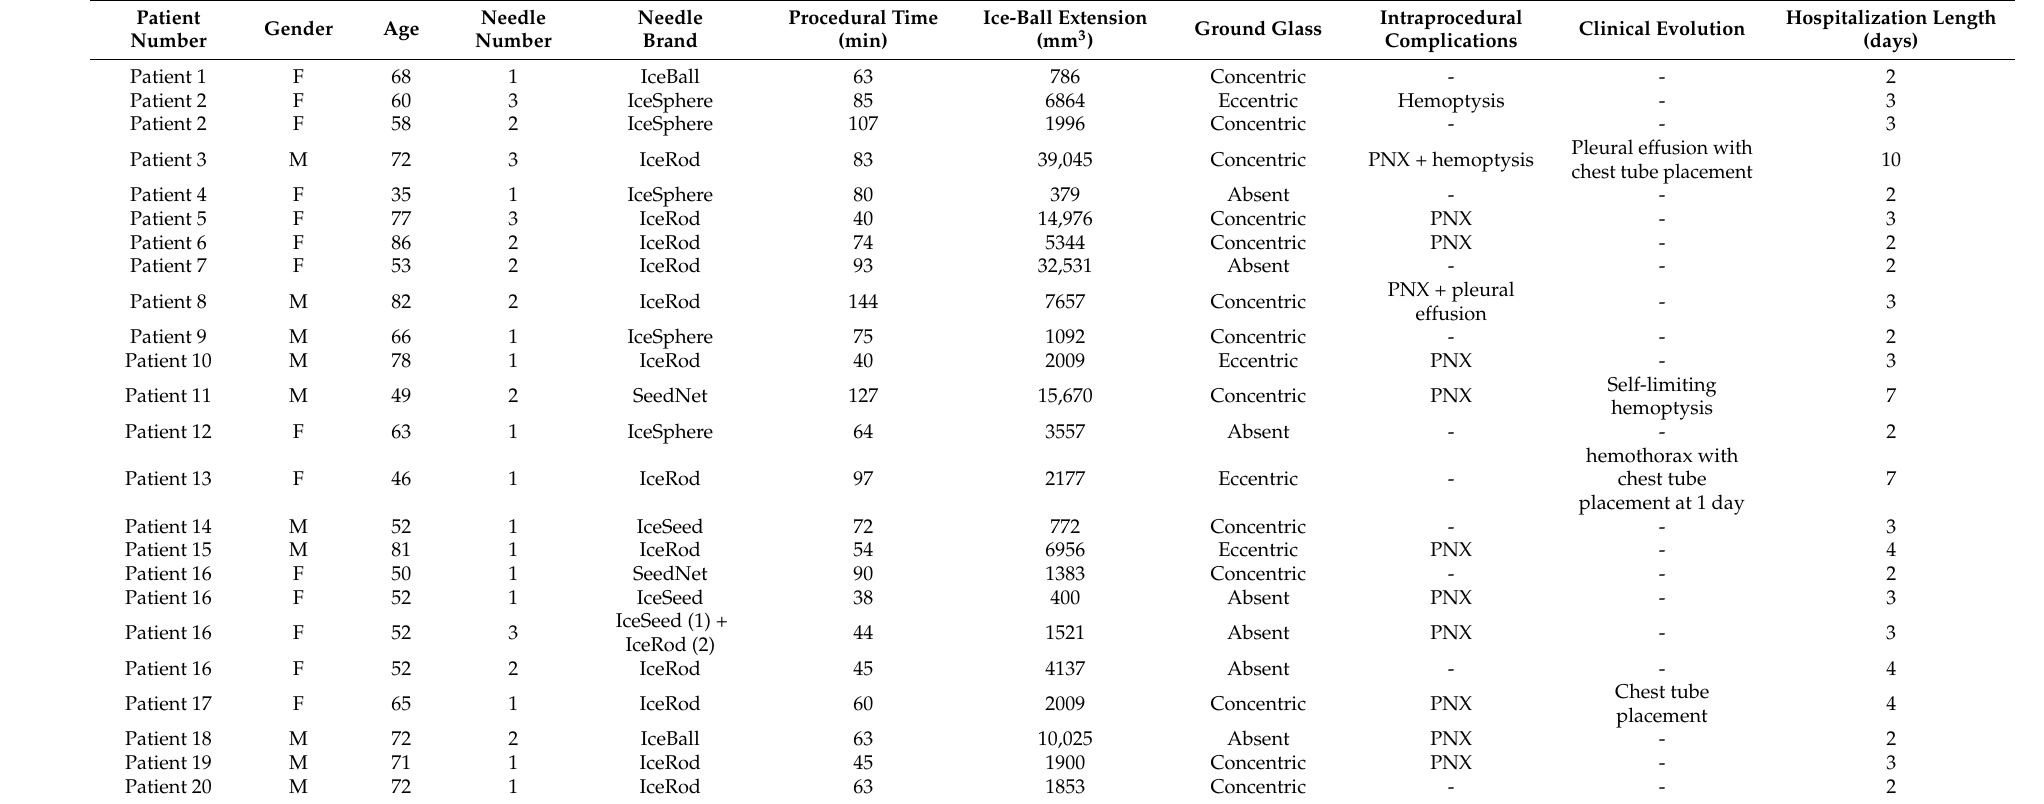
Table 2. Procedural